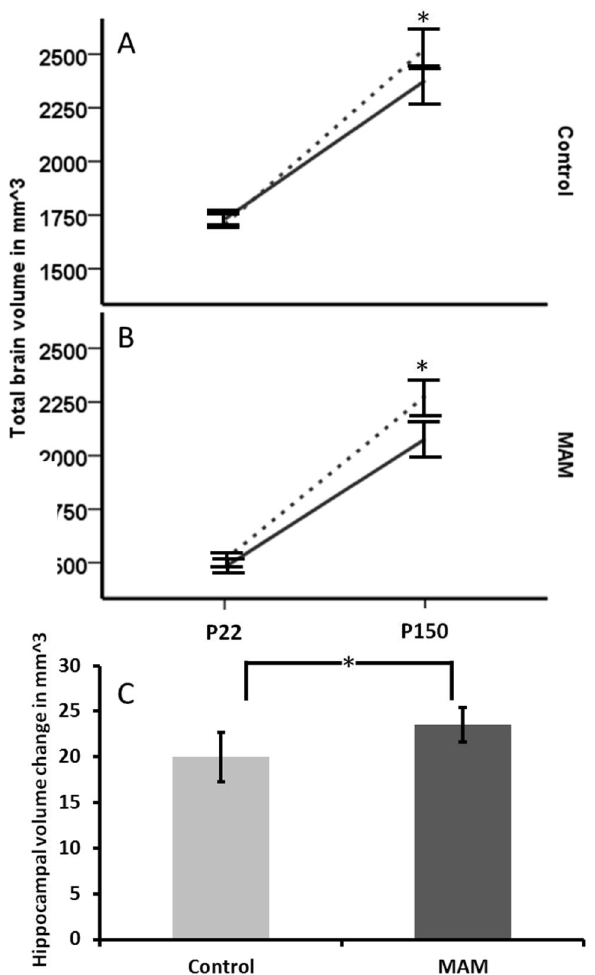
Figure 7. Longitudinal examination of whole brain and hippocampal growth from pre and post enrichment (or non-enrichment) MRI scans. ( A ) Control animals did not differ at the initial scan, but at P150 there was a significant difference between those housed in enriched vs. non-enriched settings (time*enrichment interaction; p=0.022). ( B ) The same was true for MAM animals. There was no enrichment effect in the hippocampal volumes (p=0.624). ( C ) For the hippocampus but not the whole brain, there was an effect of MAM on growth longitudinally (time*MAM interaction; p=0.009) as shown by a greater volume change over time in the MAM hippocampus compared to the controls. Error bars represent standard